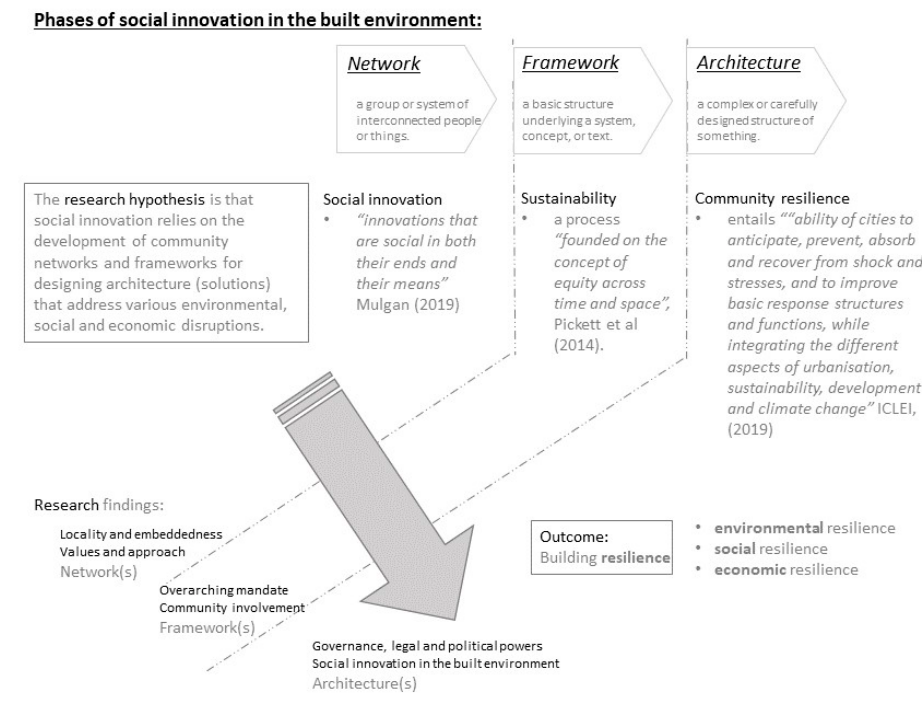
Figure 1. Conceptual framework showing phases of social innovation in the built environment.